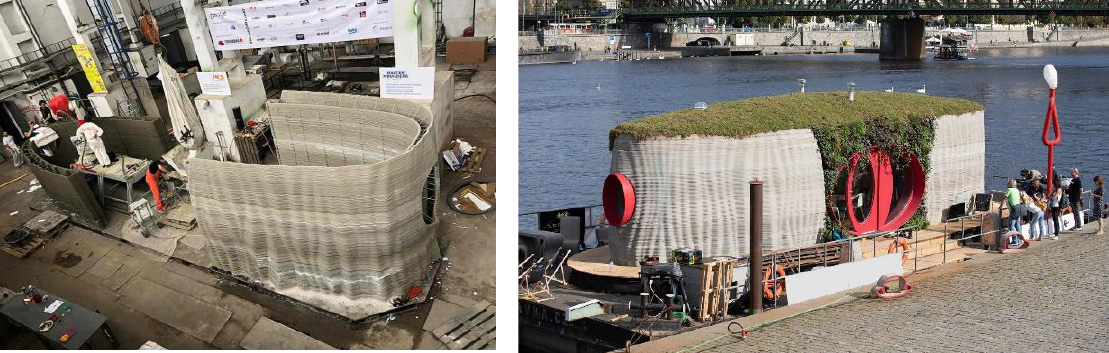
Source: Bydleni raz dva czechcrunch